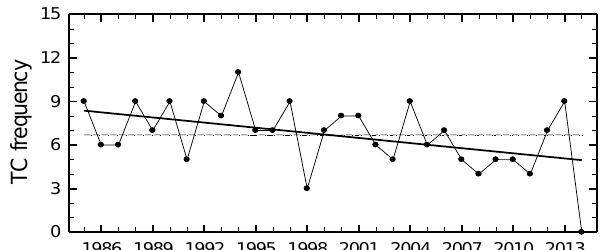
Figure 1. Time series of TC genesis frequency in August in the western North Pacific. Dashed and thick solid lines denote a climatological mean TC genesis frequency and trend, respectively.